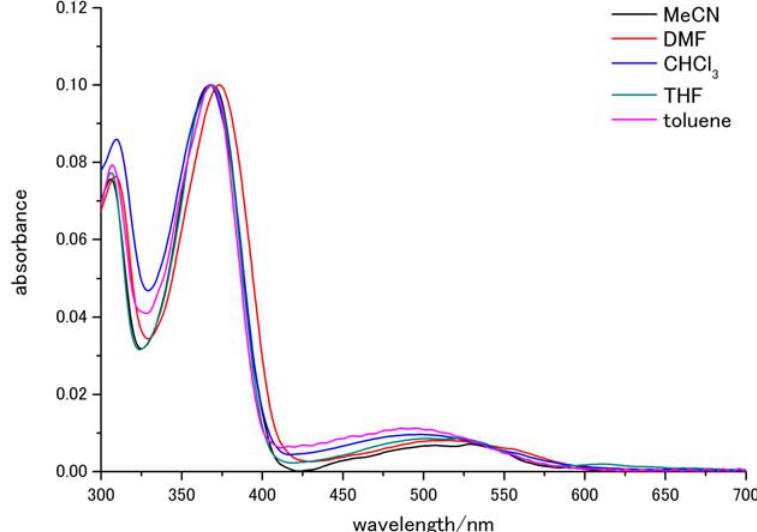
Figure 1. Absorption spectra in various solvents (smoothed by an FFT